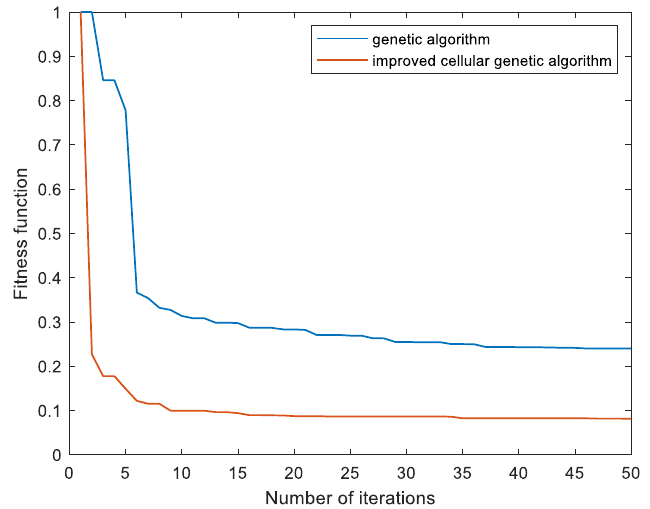
Figure 9. Comparison of fitness between the improved CGA and GA.